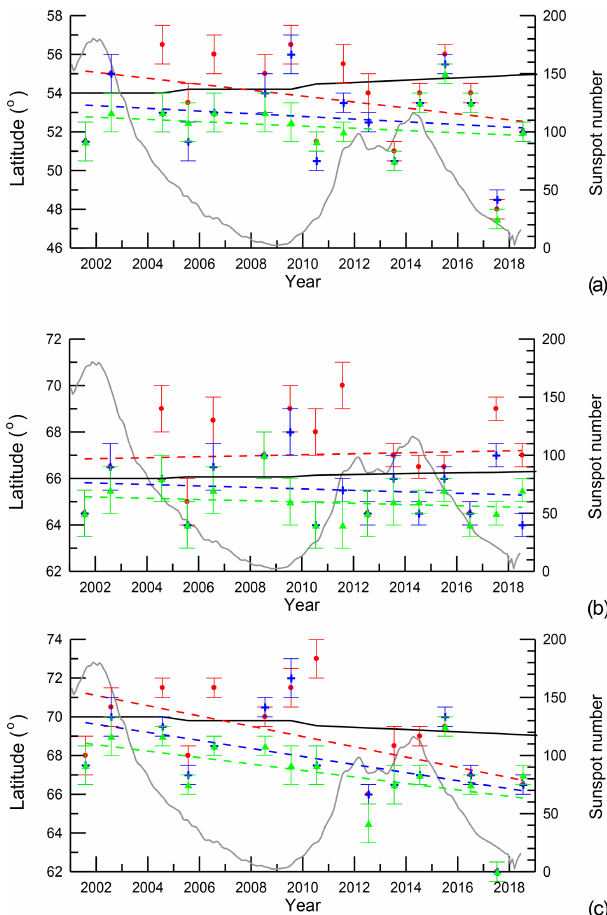
Figure 5. The same as Fig. 4 but for the inner edge of the ORB. Coefficients of the best linear fit are presented in Table 4. Table 4. Coefficients of the best linear fit of the latitudinal change of the ORB inner edge location by year for various longitudes and electron